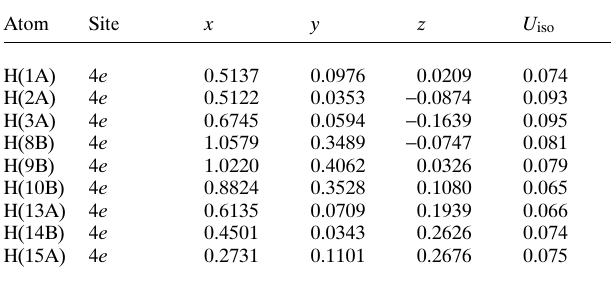
Table 2. Atomic coordinates and displacement parameters (in Å 2 )